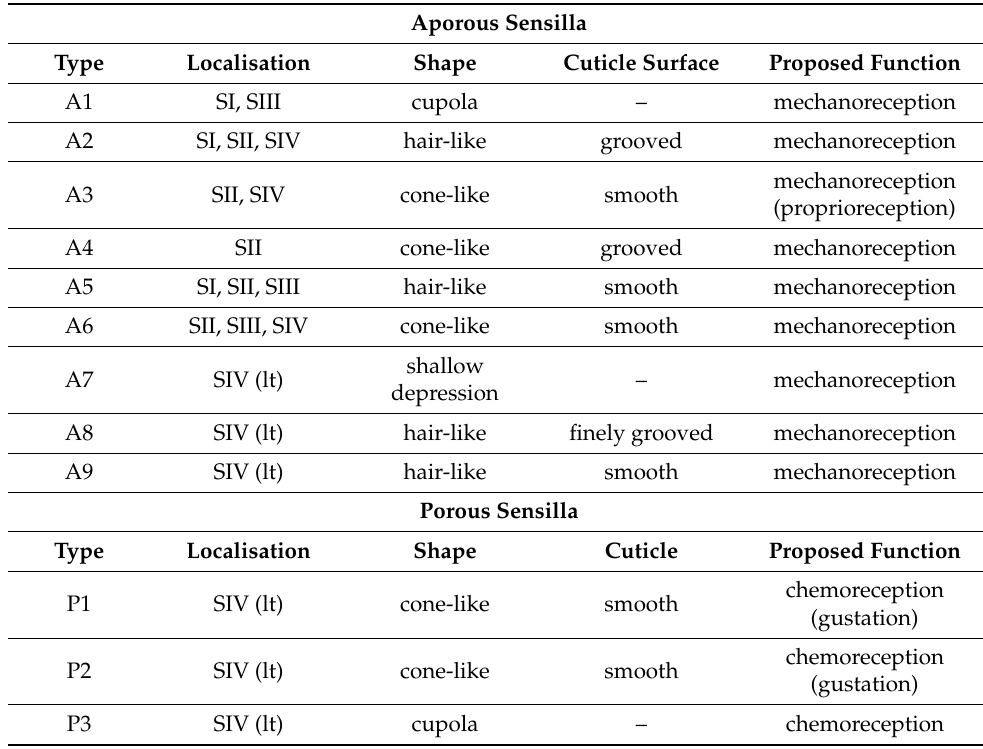
Table 1. Characteristics of the identified types of sensory organs. SI–SIV—numbers of labial segments (lt)—labium